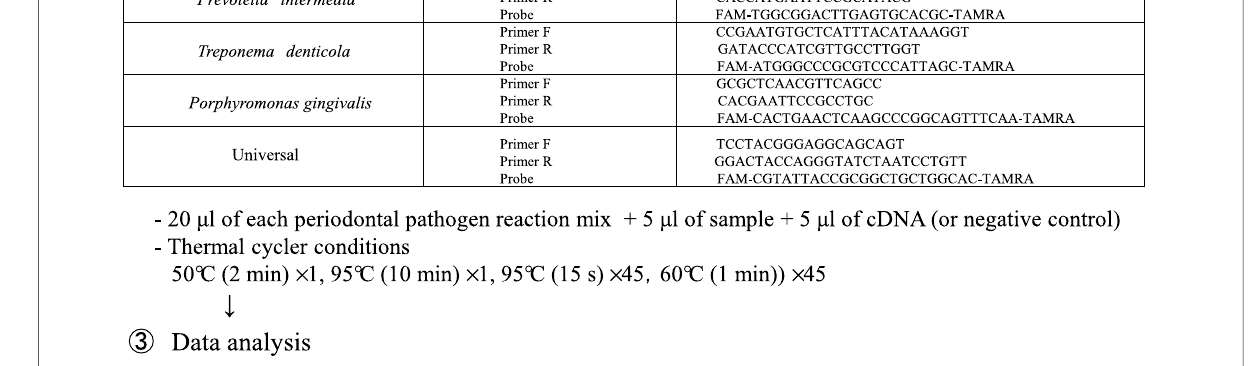
Fig. 2 Taqman ® real-time polymerase chain reaction assay was employed to determine the count of the targeted infectious agents using the primers and techniques